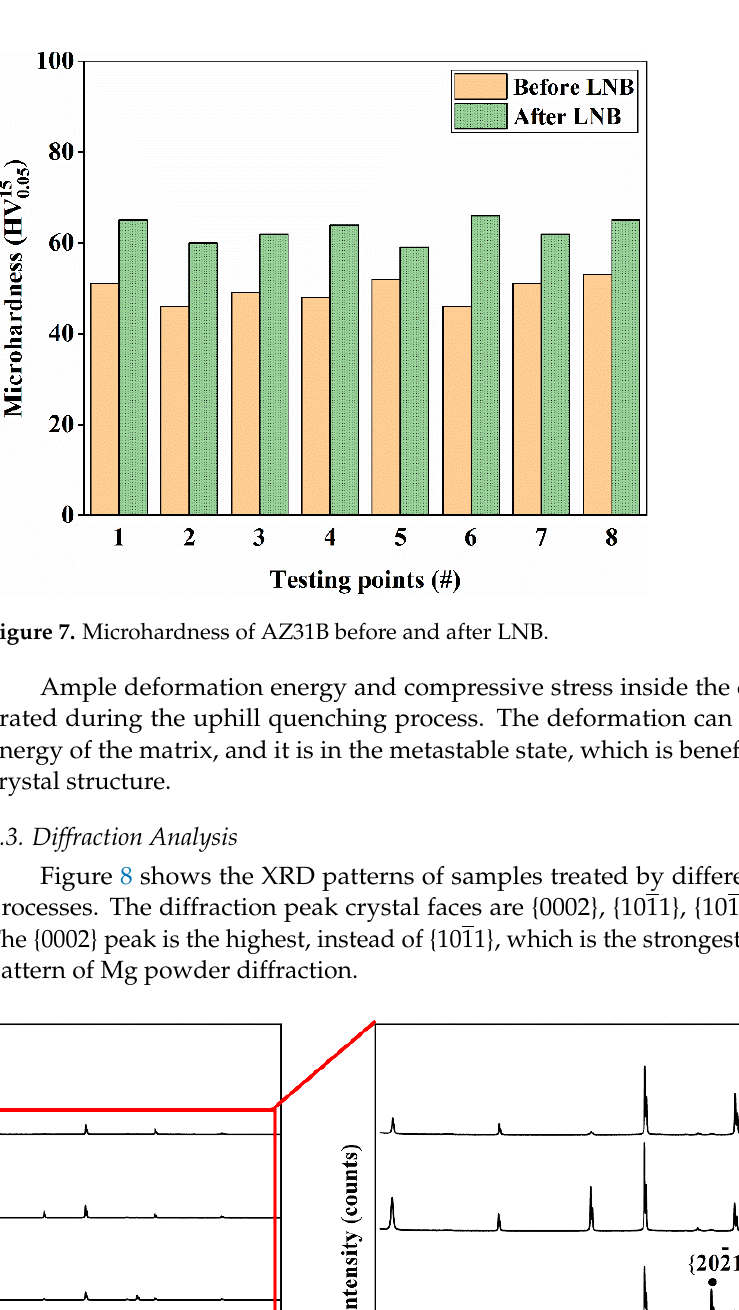
Figure 8. XRD patterns of AZ31B plates processed with different uphill quenching processes.